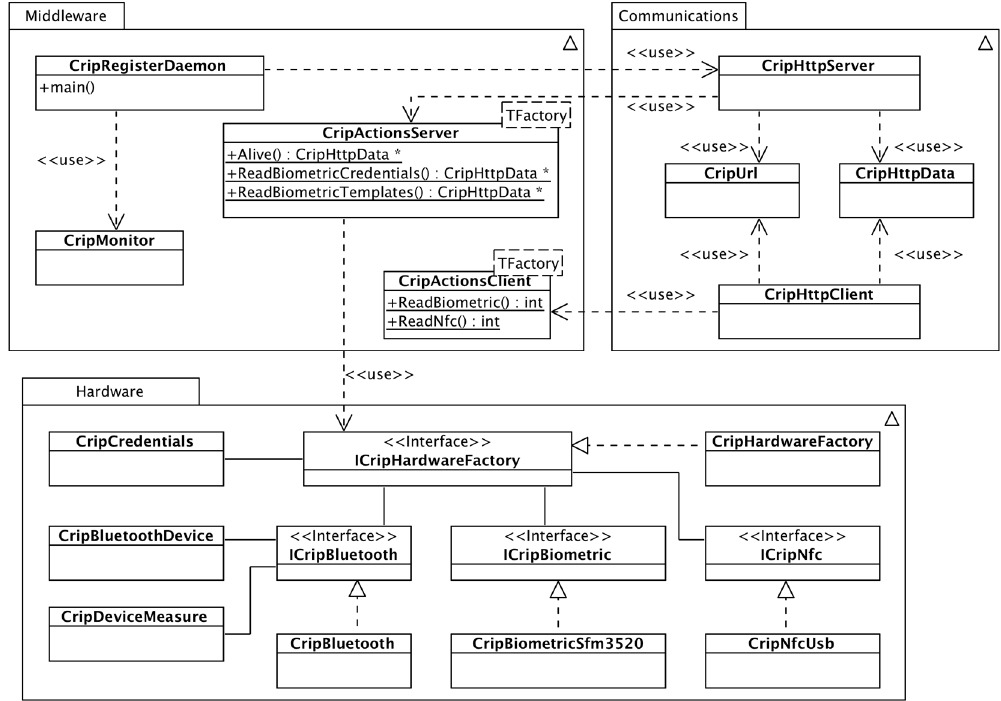
Figure 4. Software architecture for the CRIP daemon.